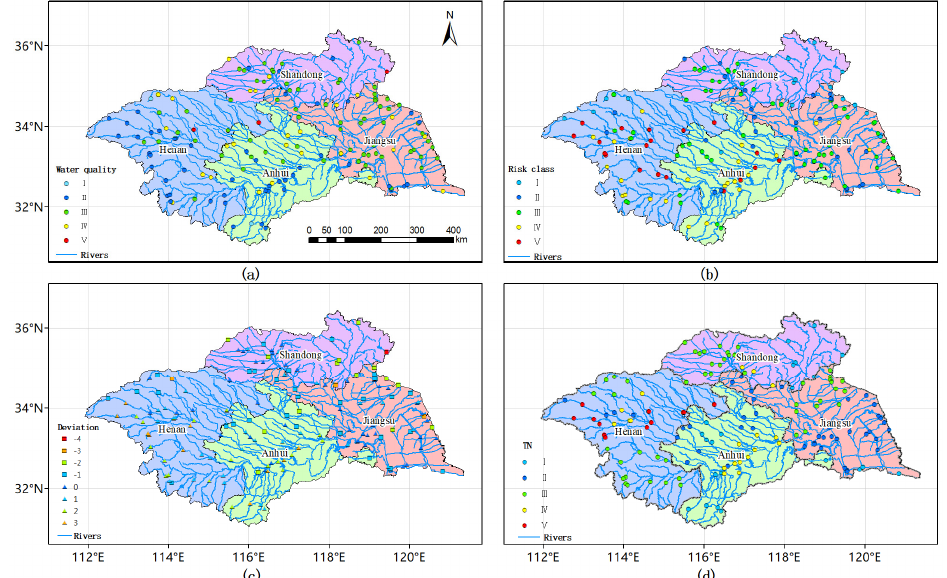
Figure 6. The water quality ( a ), risk class ( b ), the deviation between water quality and risk class ( c ), and TN distribution ( d ) of monitoring